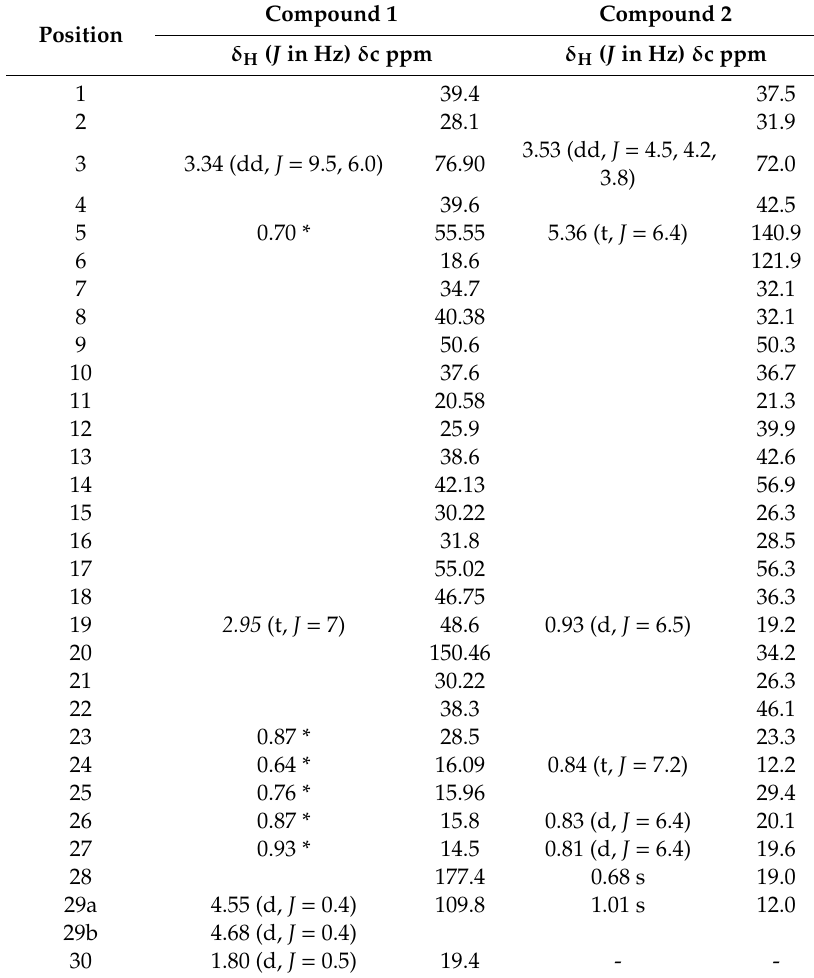
Table 1. 1 H and 13 C-NMR data for compounds 1 and 2 (CD 3